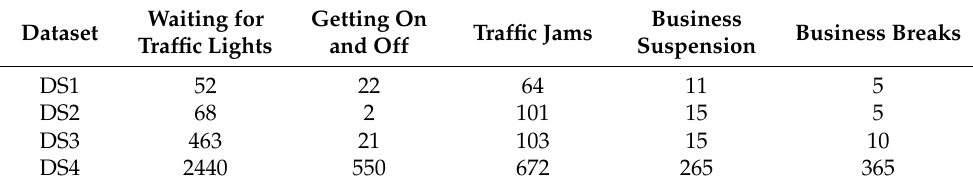
Table 4. Number of stay points resulting from different